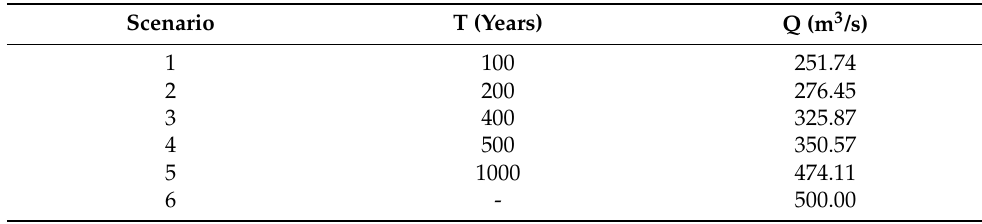
Table 2. Flow rates based on each